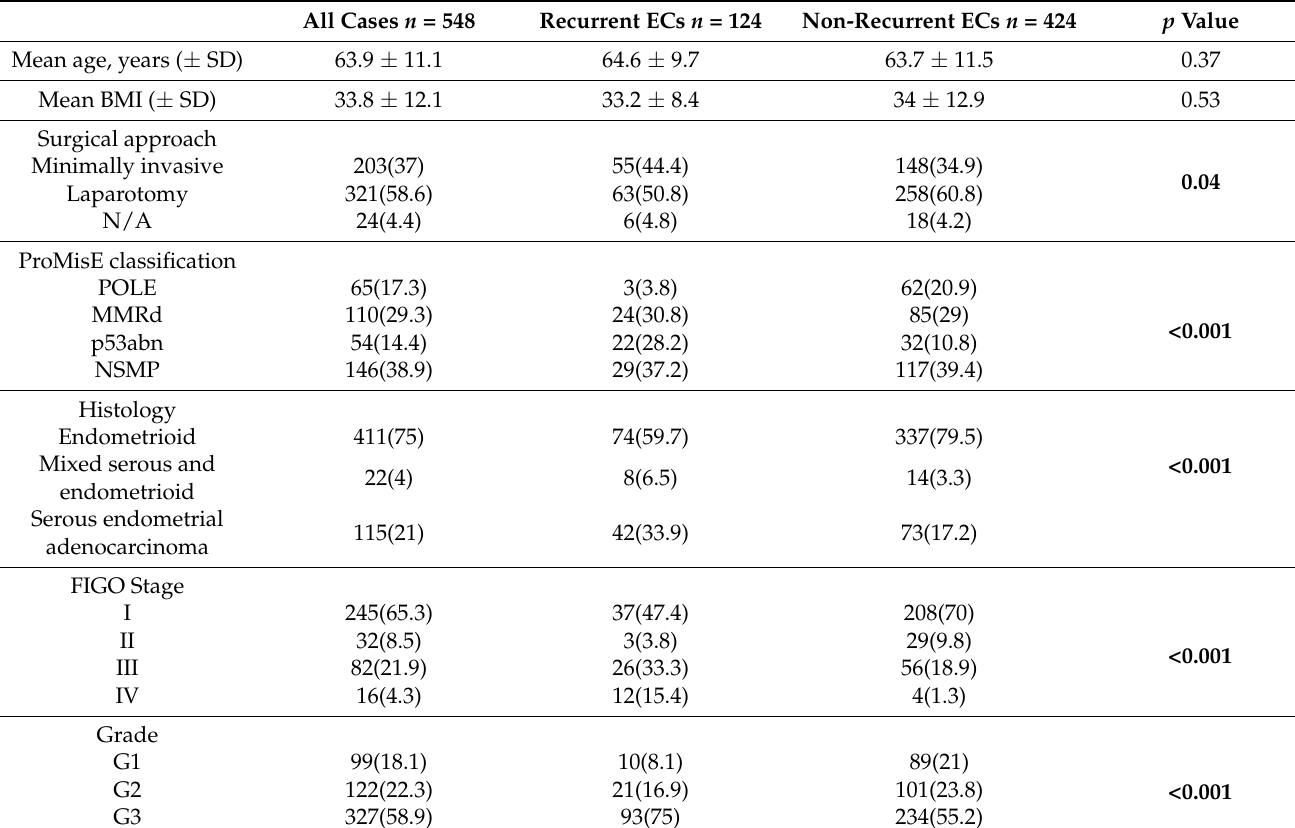
Table 5. TCGA study cohort: patient and pathologic characteristics of recurrent and non-recurrent